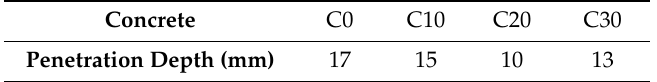
Table 5. Depth of water penetration in concrete with basalt dust